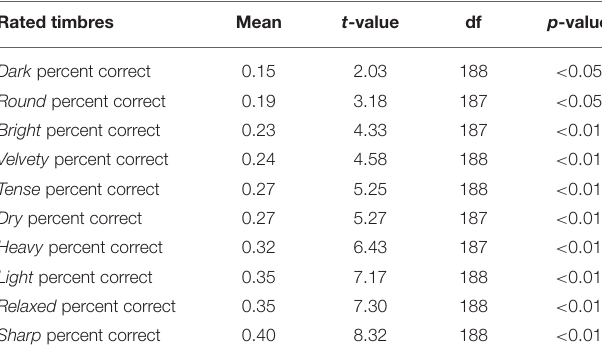
TABLE 3 | T -value, p -value, and mean score of absolute percent correct in the one-sample t